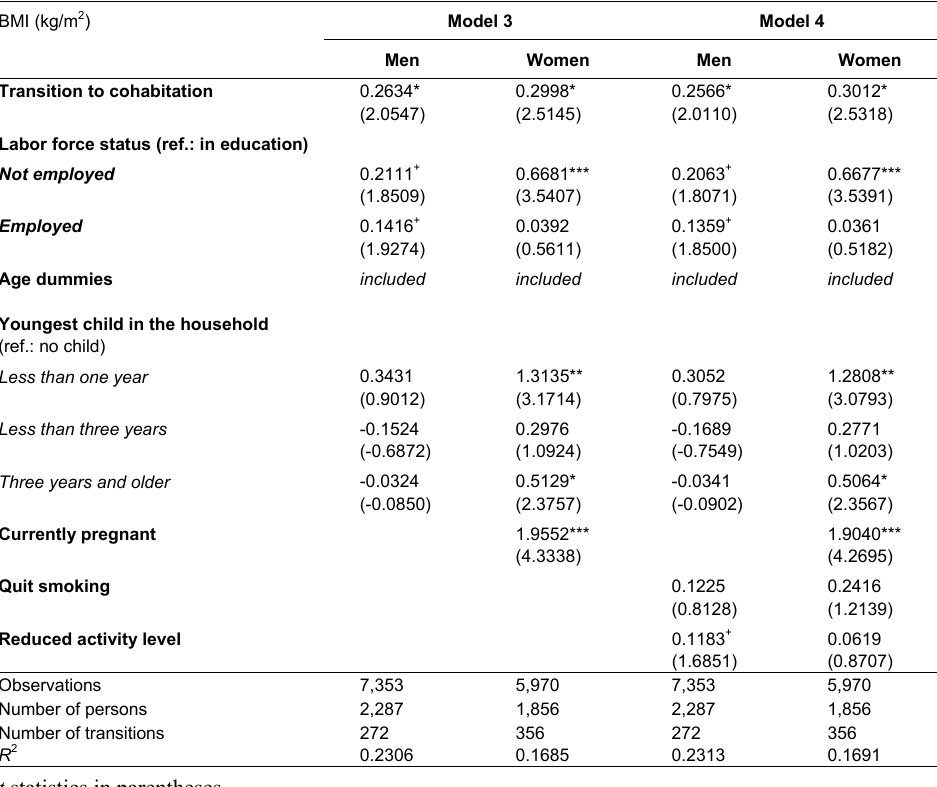
Fixed effects estimation results of transition to unmarried cohabitation